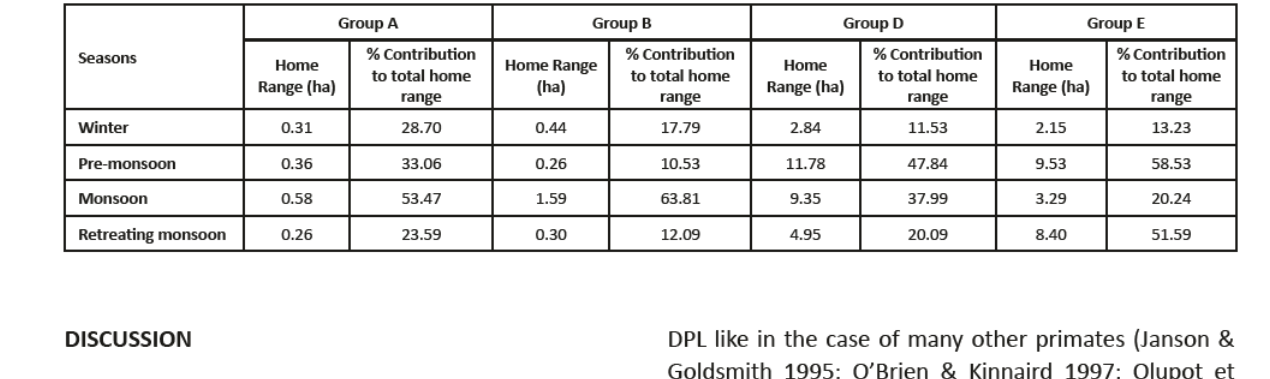
Table 4. Seasonal home range, esffimatted by mffinffimum convex polygon metthod, used by H. leuconedys groups and ttheffir percenttage conttrffibuffion tto ttottal home range.